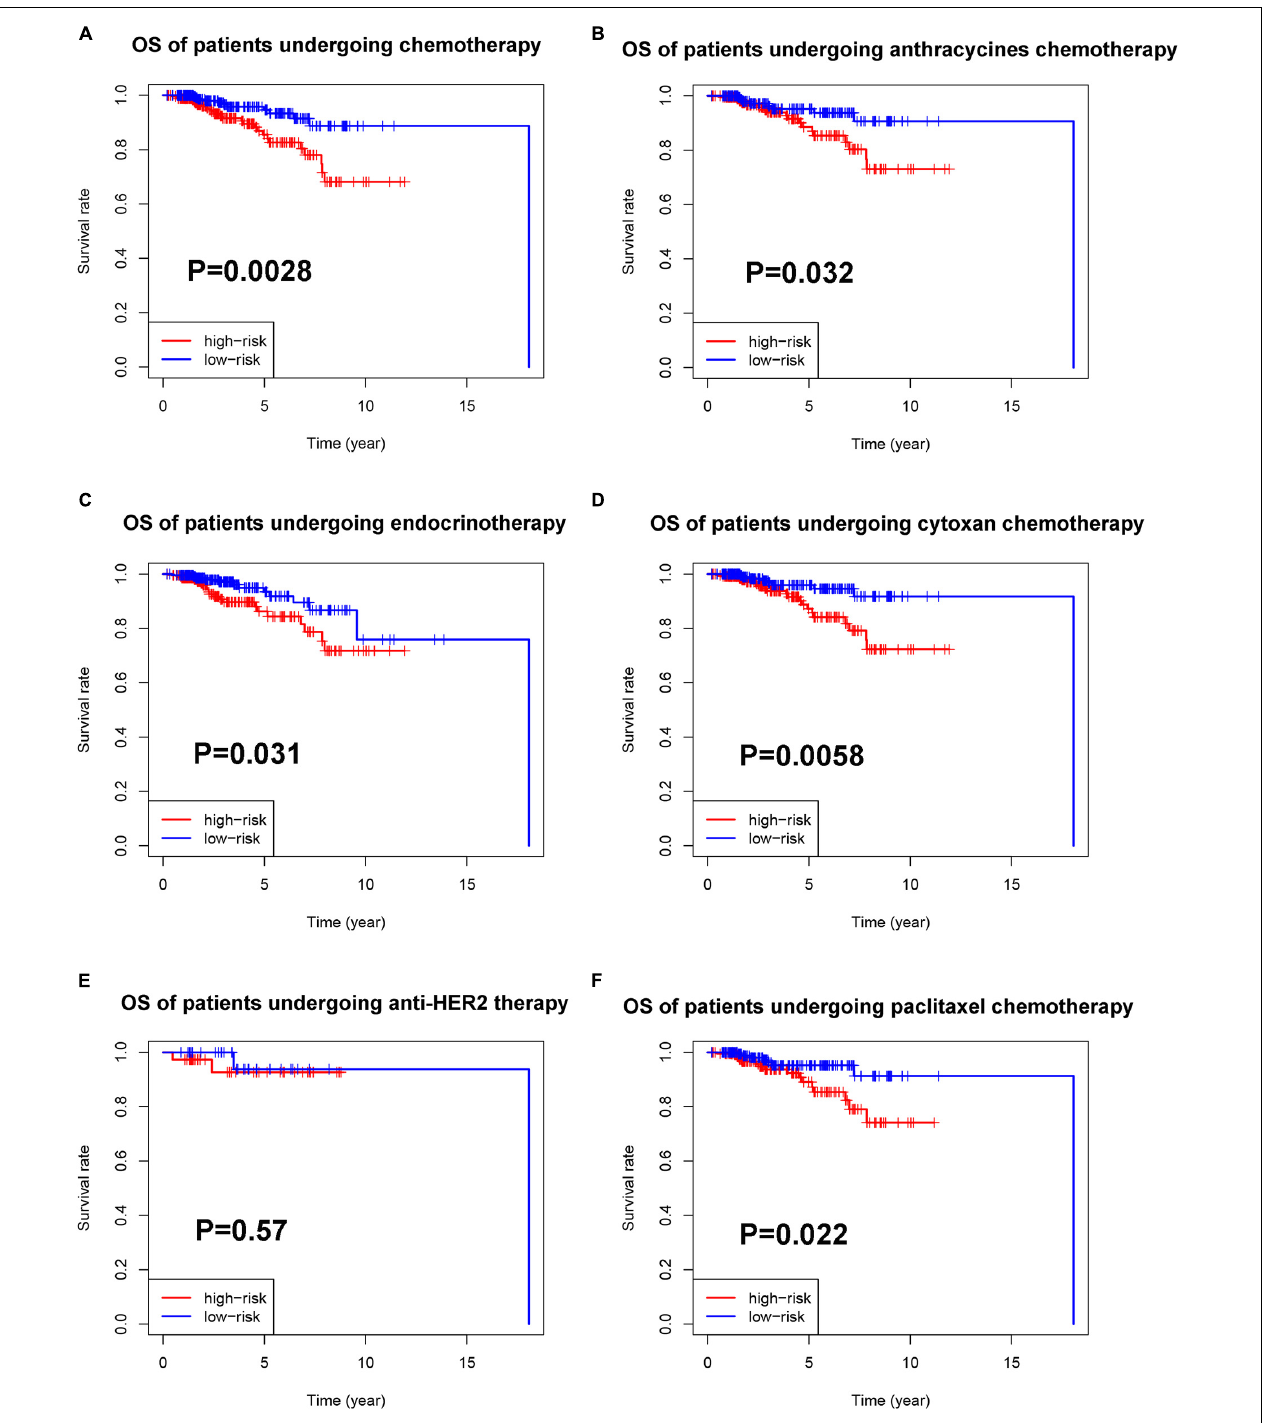
FIGURE 10 | Prognostic value of the pyroptosis-associated lncRNA signature in patients receiving different treatments. (A) Kaplan–Meier curves for the OS of patients receiving chemotherapy between the high-risk and low-risk groups. Kaplan–Meier curves for the OS of patients receiving anthracycline (B) , cyclophosphamide (D) , and paclitaxel (F) between the high-risk and low-risk groups. (C) Kaplan–Meier curves for the OS of patients receiving endocrinotherapy between the high-risk and low-risk groups. (E) Kaplan–Meier curves for the OS of patients receiving anti-HER2 therapy between the high-risk and low-risk groups.